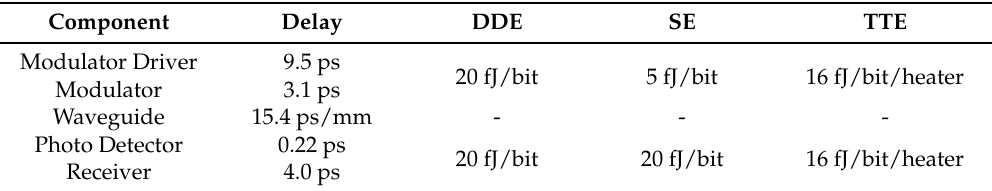
Table 2. Delay, energy of photonic elements (32 nm)